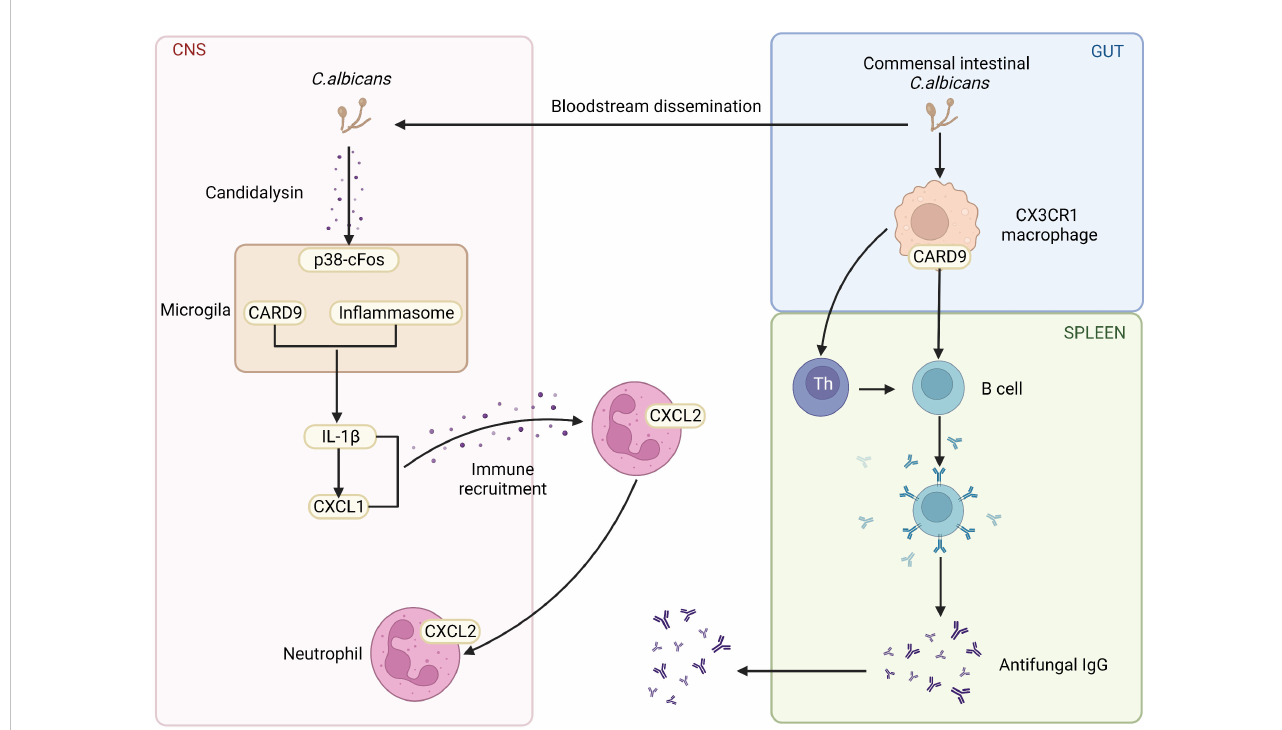
FIGURE 2 The role of CARD9 pathway in the brain and gut. Commensal Intestinal C. albicans induce the production of antifungal IgG. CARD9 and CX3CR1 double- positive macrophages promote the generation of antifungal IgG. CARD9-de fi ciency increases the susceptibility of fungal-speci fi c CNS-targeted infection. In the fungal-infected CNS, microglia rely on CARD9 for producing IL-1 b and CXCL1, which recruits neutrophils to clear the fungi. (Created with